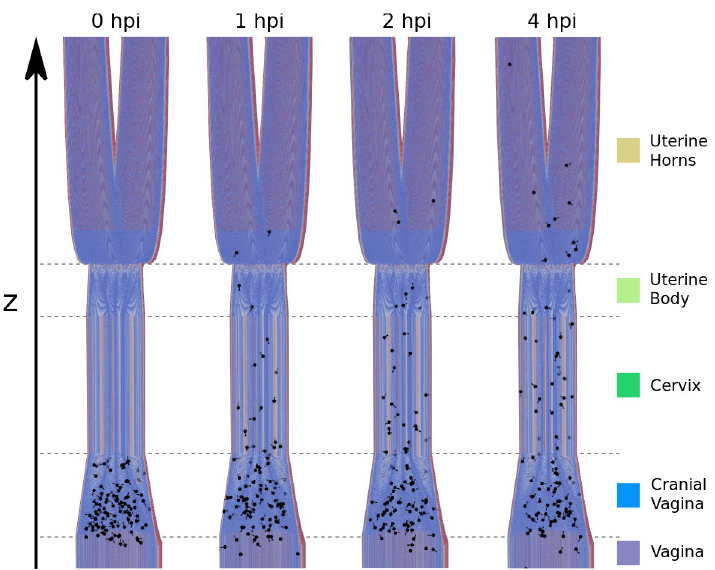
Fig 3. Sperm migration in the female genital tract. Agents are positioned in the cranial vagina and explore the space over time in hpi (hours post insemination). The z-position of the agents is the main observable of the system, defining in which compartment an agent is located. For better visibility, sperm were magnified and the genital tract truncated.